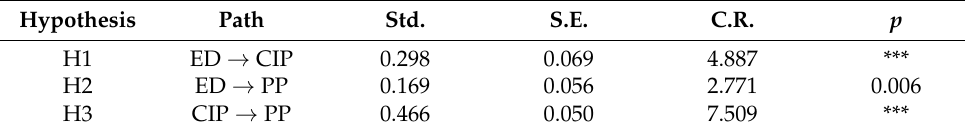
Table 13. Path coefficients and causality test for hypotheses.